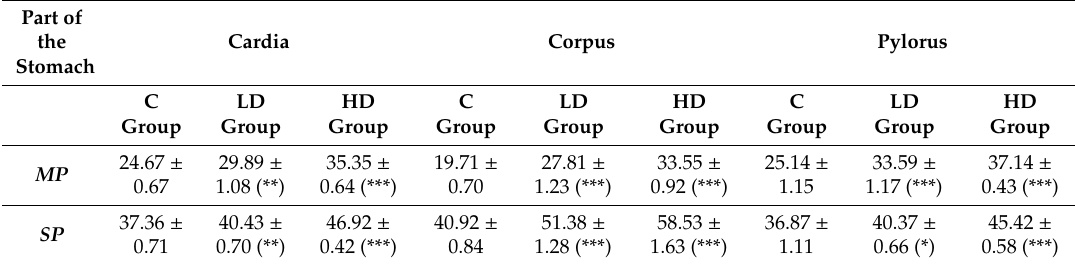
Table 1. GAL-LI immunoreactive neurons in various parts of the porcine stomach under physiological conditions (C group) and after low dose (LD group) or high dose (HD group) of acrylamide administration.